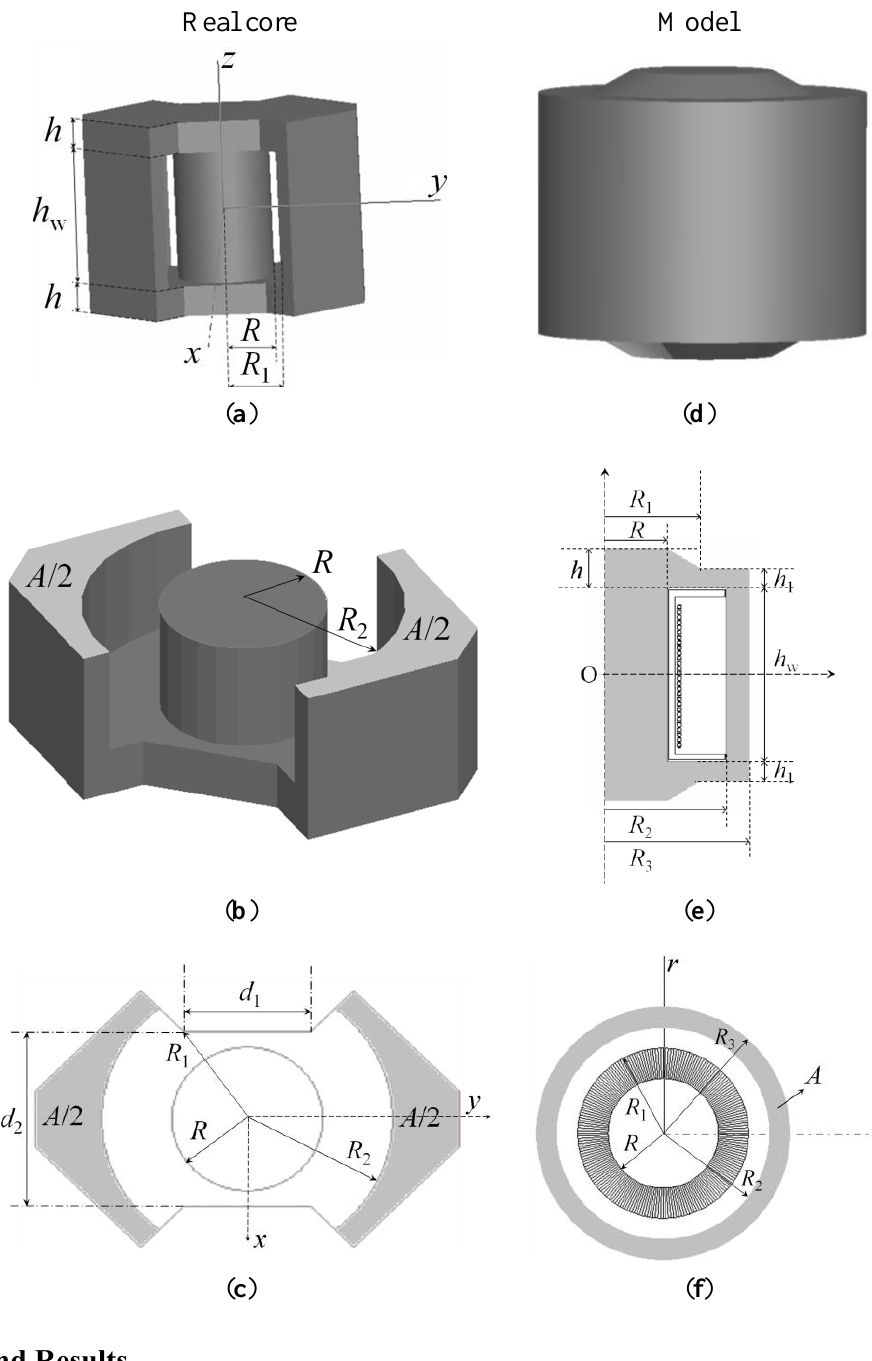
Figure 1. ( a ) RM-shaped real core; ( b ) RM-shaped core half; ( c ) cross-section in the x - y plane of the RM core; ( d ) solid of revolution; ( e ) 2D equivalent inductor model; and ( f ) cross-section of the solid of